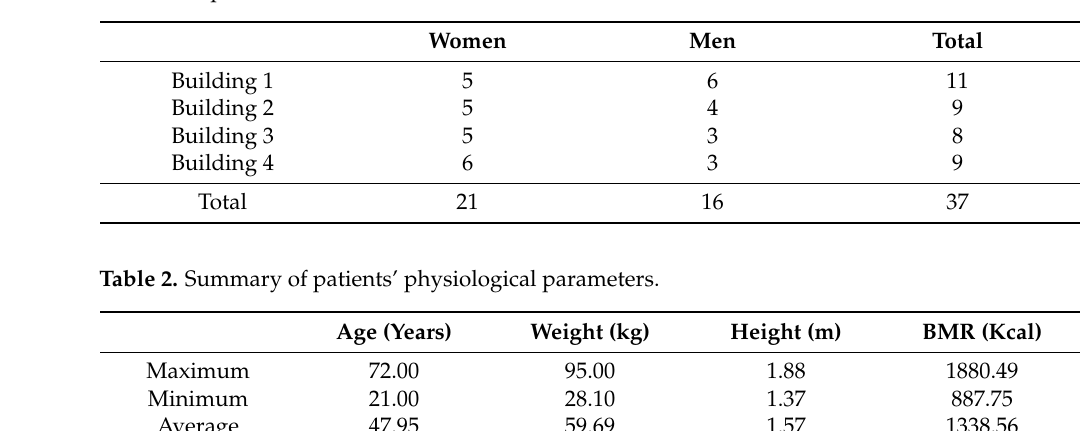
Figure 3. Surveyed building. Table 1. Population sex distribution.